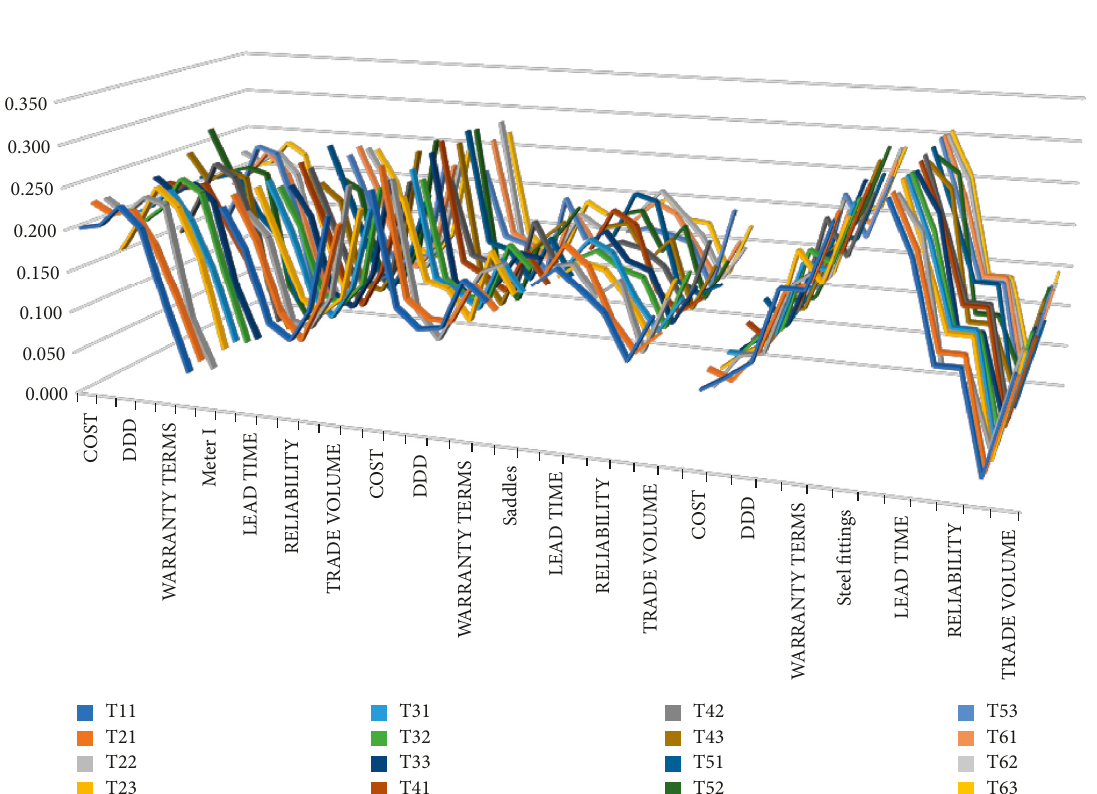
Figure 6: Variance of criteria weights according to w